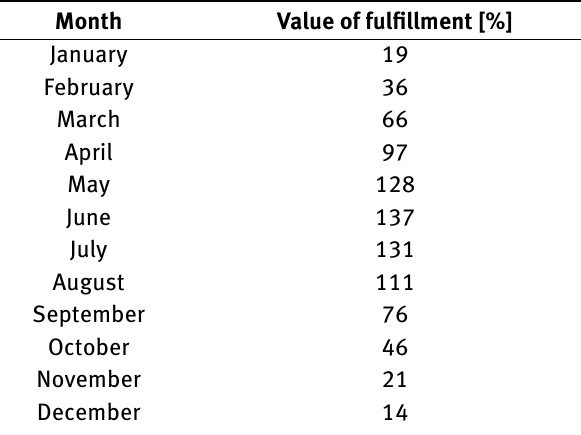
Table 5: The degree of fulfillment of the demand (Variant I).